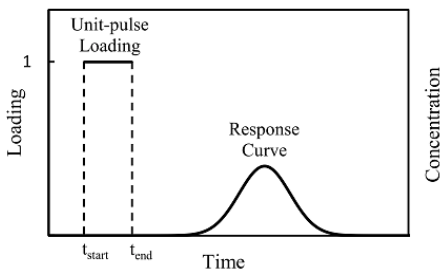
Figure 2. Schematic representation of unit-pulse loading and response curve [50].